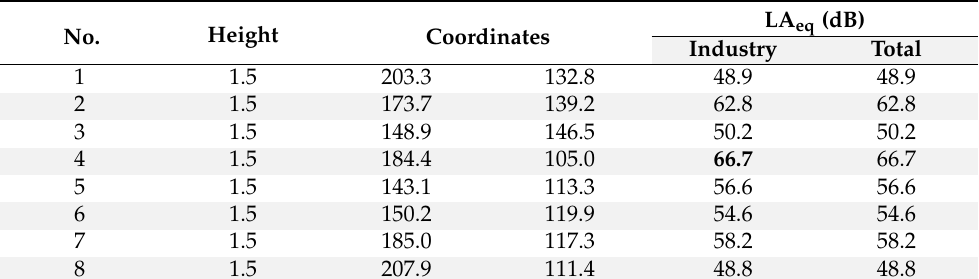
Figure 13. Colour map of isophone bands after considering acoustically significant elements with construction site fencing and a solid gate for pile-driving work in the investigated area. Table 15. Table of points from the calculation of measured points for earthworks with construction site fencing and a solid gate in the investigated area.